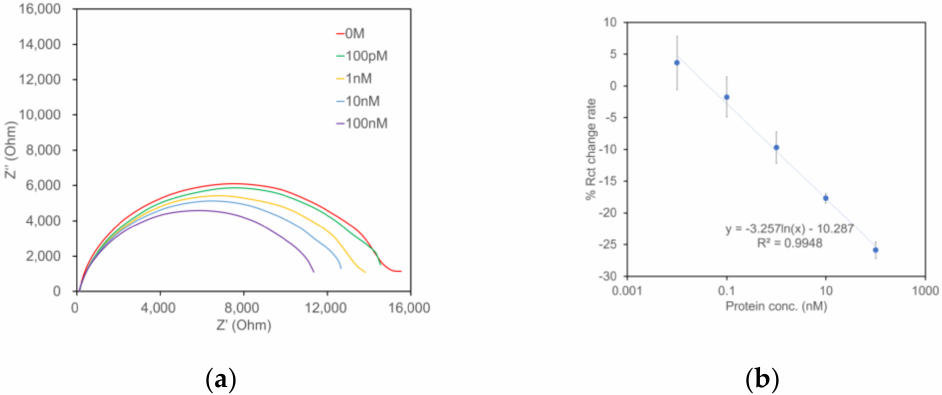
Figure 1. EIS monitoring of bevacizumab using the anti-bevacizumab aptamer A14#1 immobilized electrode. ( a ) is with the addition of bevacizumab. ( b ) is relative Rct change plotted against the bevacizumab concentration